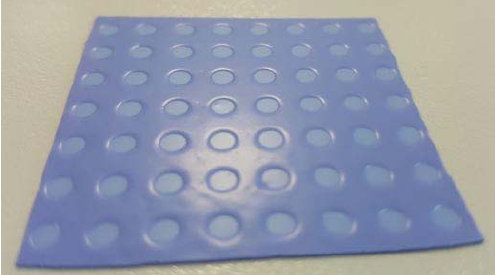
Figure 2. 20 μ m thick and 3 mm in diameter LTTC membranes stretched on rigid 100 μ m LTCC